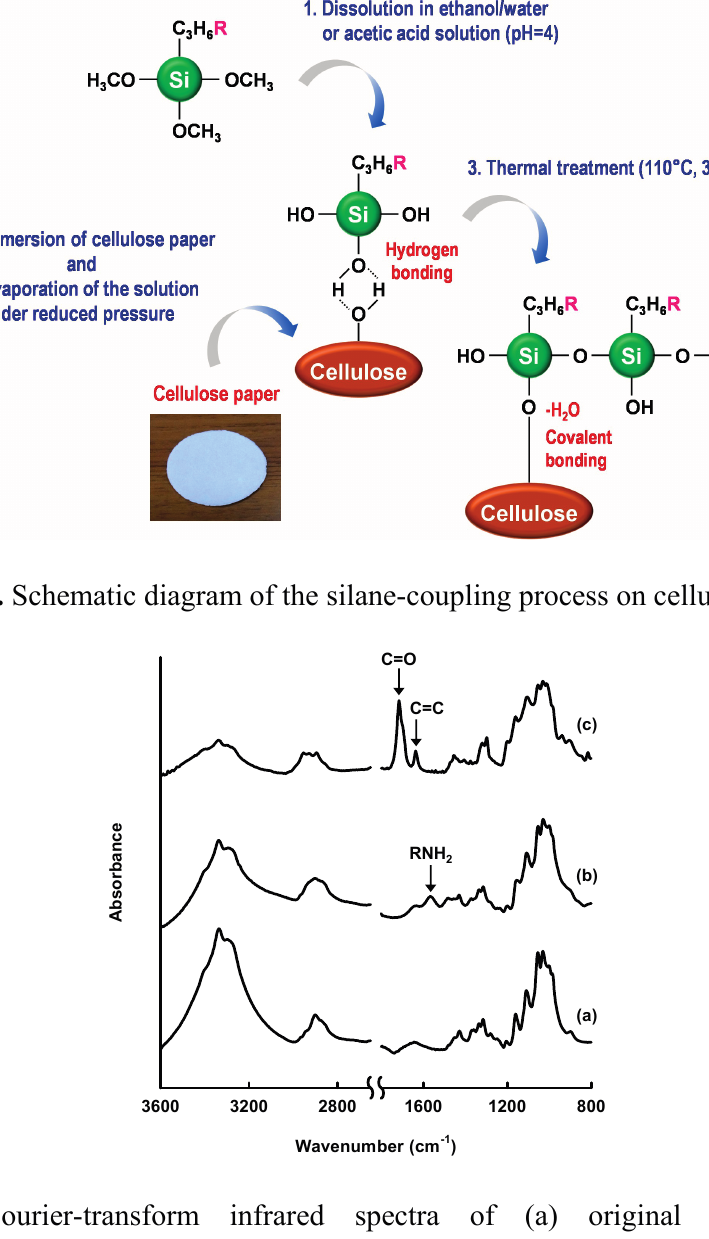
Figure 3. Fourier-transform infrared spectra of (a) original cellulose paper and cellulose paper treated with (b) 3-aminopropyltrimethoxysilane and (c) 3-(trimethoxysilyl)propyl